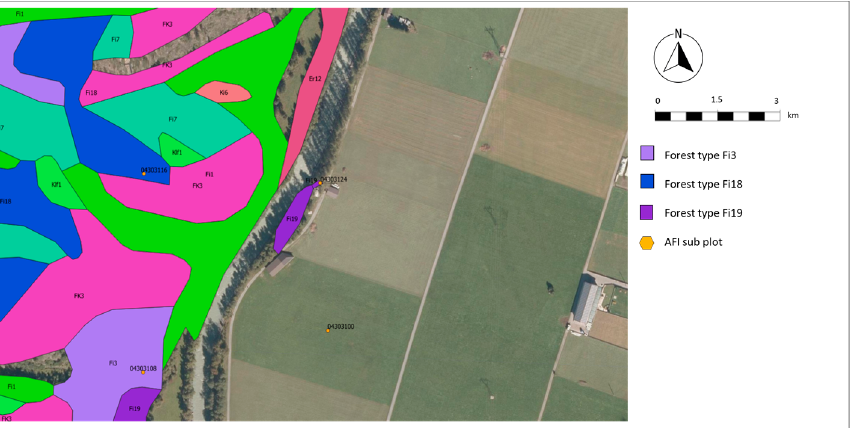
Figure 3. Assigning AFI plots to forest types (47 ◦ 24 (cid:48) 59.99 (cid:48)(cid:48) N, 1 ◦ 27 (cid:48) 59.99 (cid:48)(cid:48) E). AFI plots (orange dots, numerical codes) are assigned to forest types (colored areas, alpha-numerical codes) in QGIS by position (e.g., 04303108 to Fi3) or photo referencing (e.g., 04303124 to Fi19). AFI subplots without AFI data located outside of forest type objects are excluded from analysis (e.g.,